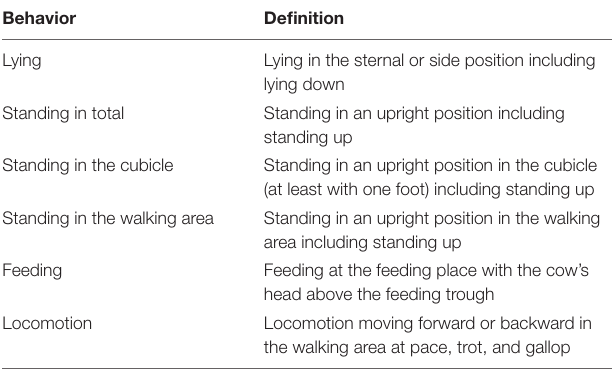
TaBle 2 | list of time budget parameters and their